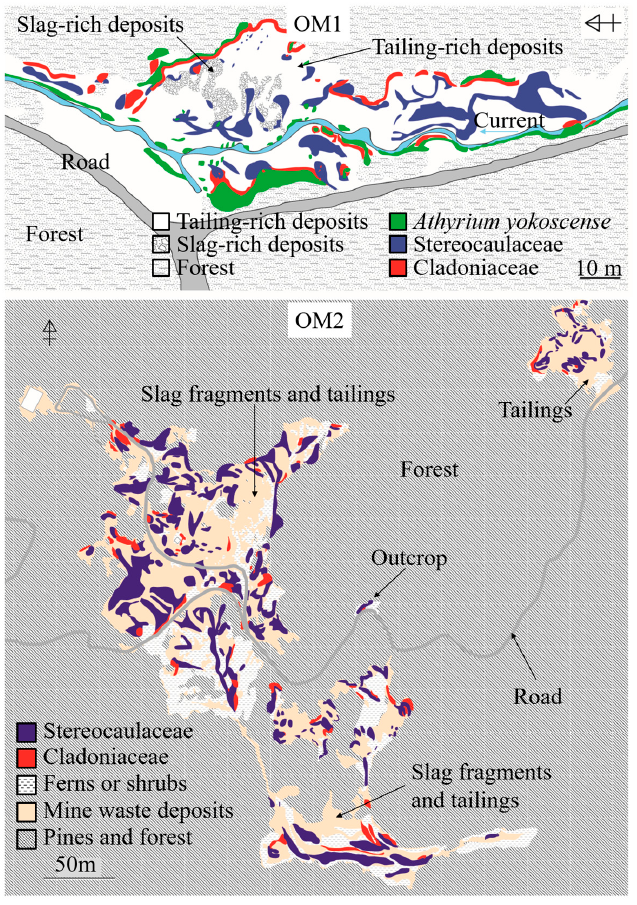
Figure 3. Distribution maps of lichens on mine waste dumps in the study areas OM1 and OM2.